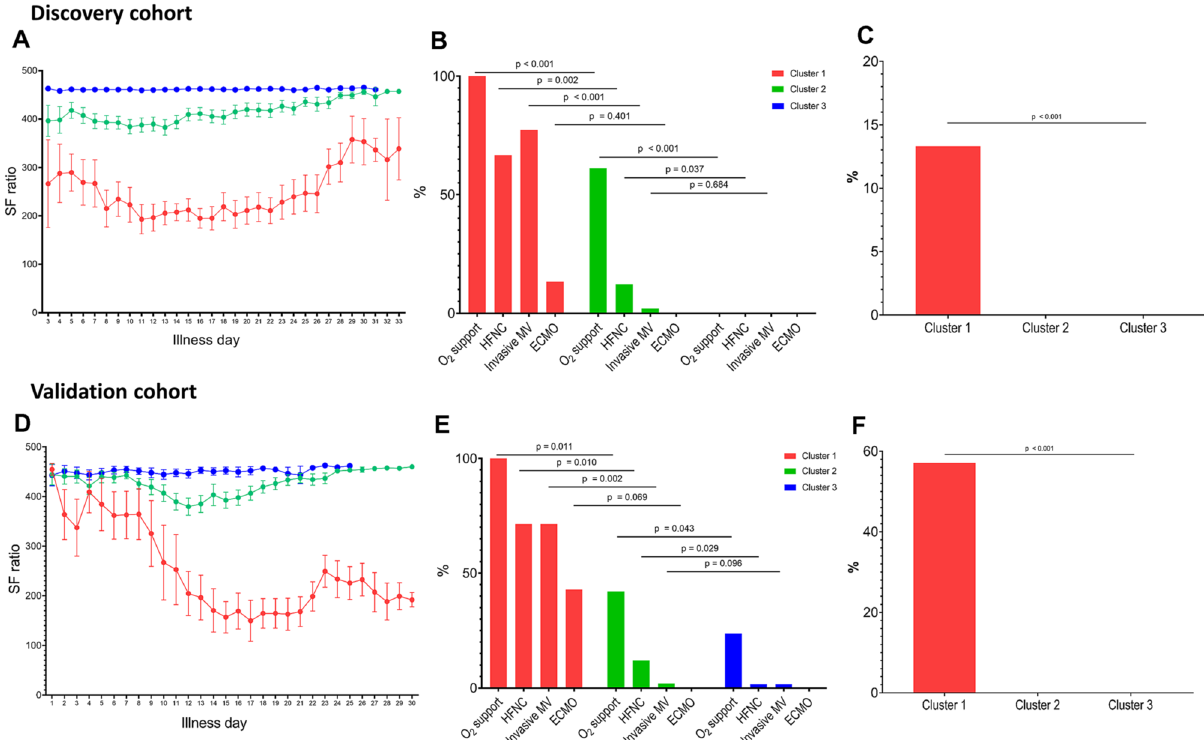
Figure 3. Association between three distinct patterns of inflammatory responses and disease severity in discovery cohort and validation cohort. Oxygenation status of the discovery cohort ( A ) and the validation cohort ( D ), expressed as the pulse oximetry saturation/fraction of inspired oxygen ratio (SF ratio) during hospitalization, depicted according to cluster. “Illness day” denotes the number of days from first